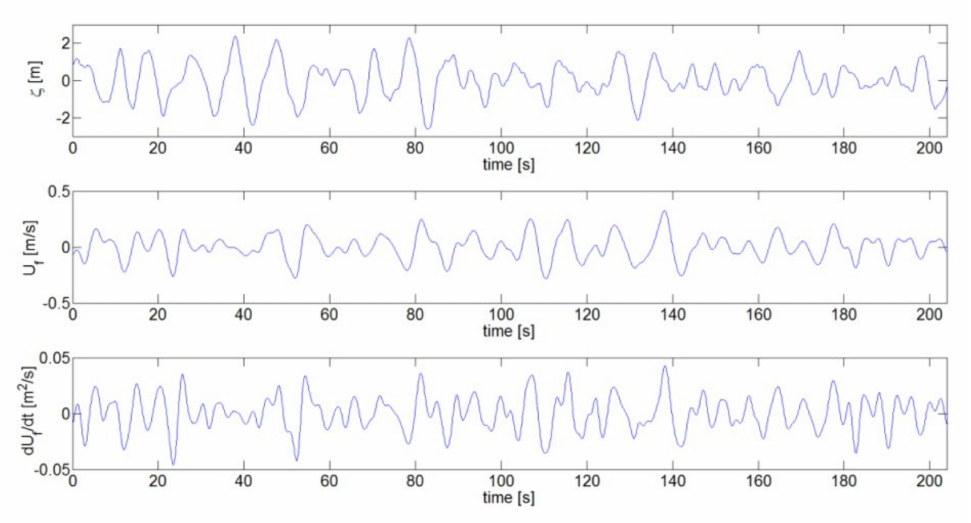
Figure 15. Numerically simulated water surface displacement, velocity, and acceleration at x = 17.5 m for H s = 5 m, and T p = 10